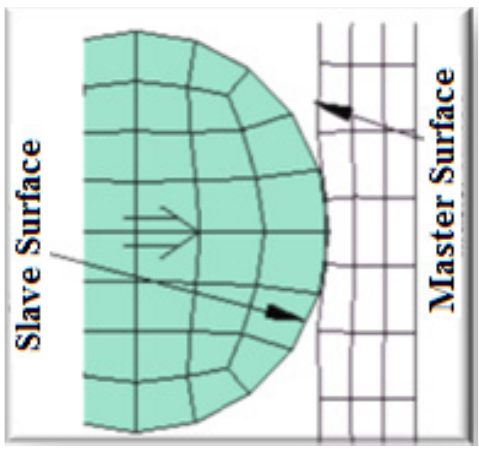
Figure 12 : Contact Pair surface.